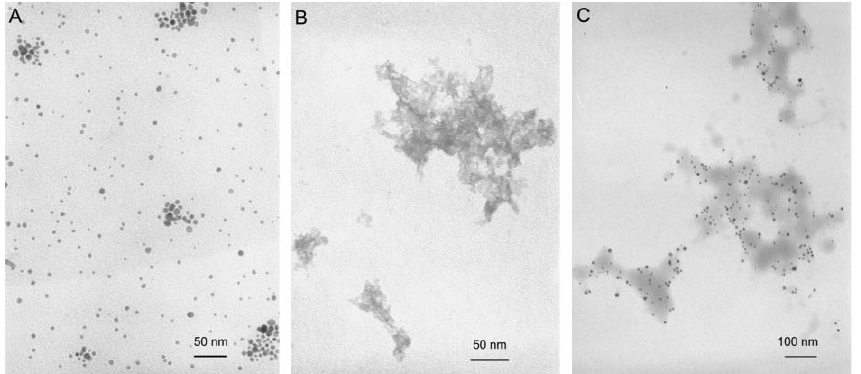
Figure 6. Ultrastructure of 2Ag nanoparticles ( A ), siRNA (siBcl-xl) ( B ), and 2Ag:siRNA (siBcl-xl) complexes prepared in a 12.5:1 dendron:siRNA molar ratio ( C